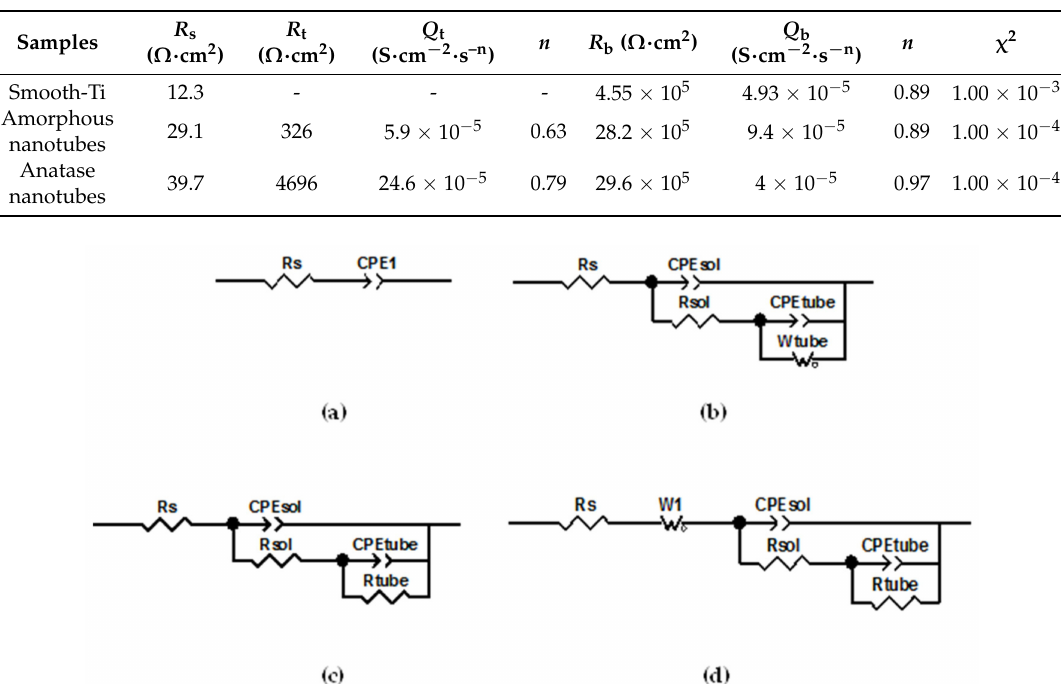
Figure 3. Equivalent circuit model used by [26]: ( a ) for smooth and ( b ) for nanotubes covered samples. Table 1. Values for the element of the equivalent circuits and chi-squared ( χ 2 ) obtained by Yu [26].